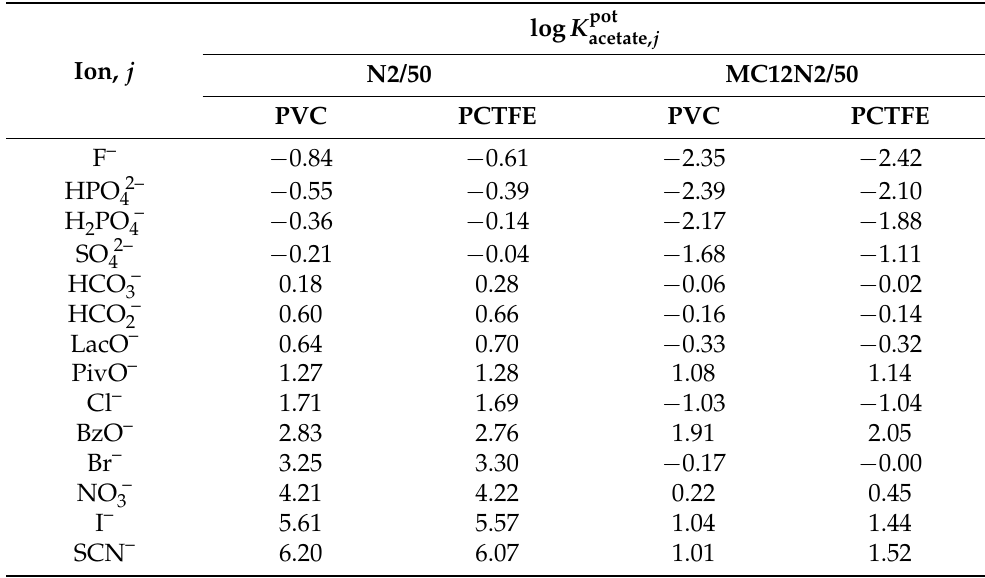
Table 3. Average potentiometric selectivity coefficients determined with the separate solution method ( a i = a j = 10 − 2.05 M) for sensors with either the best-performing ion-selective membrane or its corresponding control membrane. The number of measurements and the number of sensors were n = 1 and k = 2, respectively, unless noted otherwise. See Table A8 for standard deviations. See Table 1 for membrane